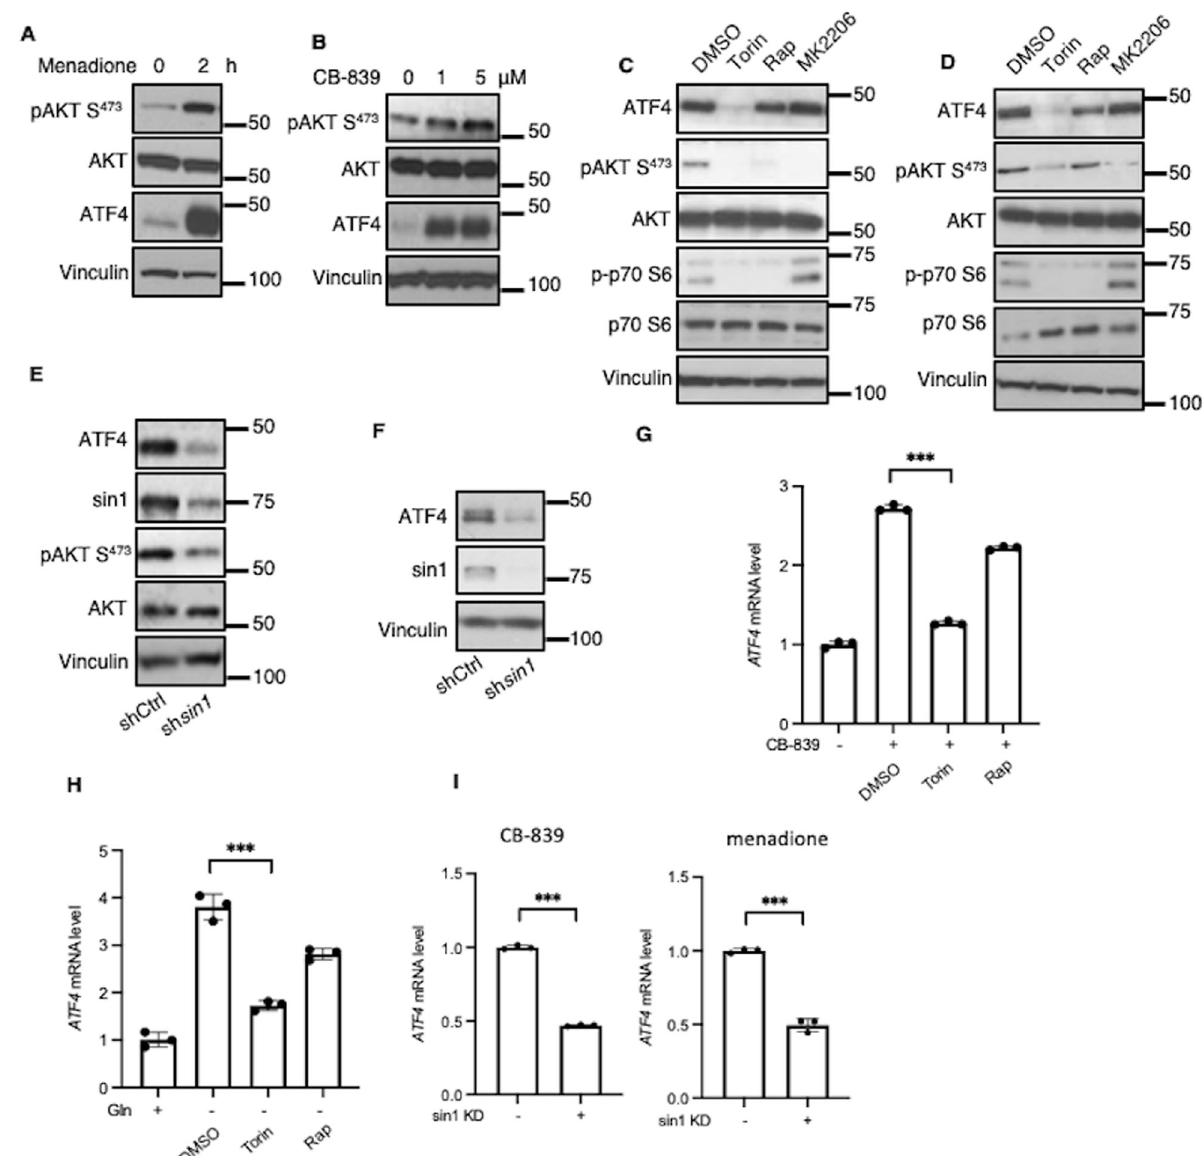
Fig. 2 mTORC2 increases ATF4 transcription independently of AKT. A Western blot analysis of WCL from MDA-MB-231 cells treated with menadione (50 μ M) for 2 h. Blots are representative of two independent experiments. B Western blot analysis of WCL from MDA-MB-231 cells treated with CB-839 (1 μ M) for 24 h. Blots are representative of three independent experiments. C , D Western blot analysis of WCL from MDA- MB-231 cells treated with CB-839 (1 μ M) ( C ) or without glutamine ( D ) ± Torin1 (500 nM), Rapamycin (50 nM) or MK2206 (5 μ M) for 24 h. Blots are representative of three independent experiments. E , F Western blot analysis of WCL from control or sin1 KD MDA-MB-231 cells cultured in glutamine-free medium ( E ) or treated with CB-839 (1 μ M) ( F ) for 24 h. Blots are representative of two independent experiments. G , H RT-qPCR quanti fi cation of ATF4 mRNA in MDA-MB-231 cells treated with CB-839 (1 μ M) ( G ) or cultured ± glutamine ( H ) for 24 h with Torin1 (500 nM), Rapamycin (50 nM) or MK2206 (5 μ M). Data shown are representative of three independent experiments and expressed as means ± SD for triplicate measurements. I RT-qPCR quanti fi cation of ATF4 mRNA in control or sin1 KD MDA-MB-231 cells treated with CB-839 (1 μ M) or menadione (10 μ M) for 24 h. Data shown are representative of two independent experiments and expressed as means ± SD for triplicate